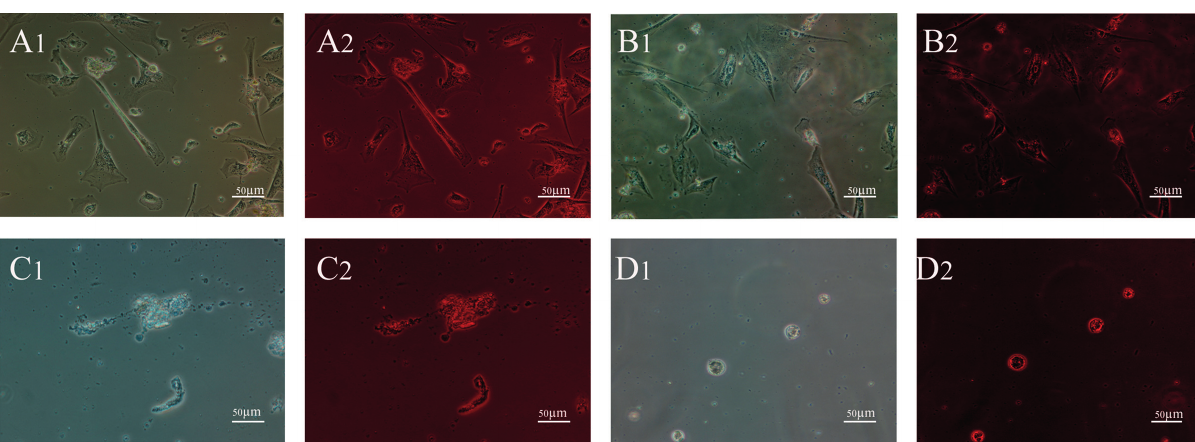
Fig. 6. Images of QD-labeled hAM-dMSCs. The images of QDs-labeled hAM-dMSCs before and after fluorescence microscope. Images of 0.75 μg/mL QD-labeled hAM-dMSCs which excite red color and keep normal morphological shape at 2d (A1 before fluorescence microscope, A2 after fluorescence microscope) and 4d (B1 before fluorescence microscope, B2 after fluorescence microscope). Images of 3.0 μg/mL QD-labeled hAM-dMSCs which were taken off the surface of the cell culture dish and shaped spherocyte at 1d (A3 before fluorescence microscope, B3 after fluorescence microscope ). Images of 1.5 μg/mLQD-labeled hAM- dMSCs which excite red color and lost fibroblast-like morphological shape at 2d (A4 before fluorescence microscope, B4 after fluorescence microscope ) Scale bar = 25 μm